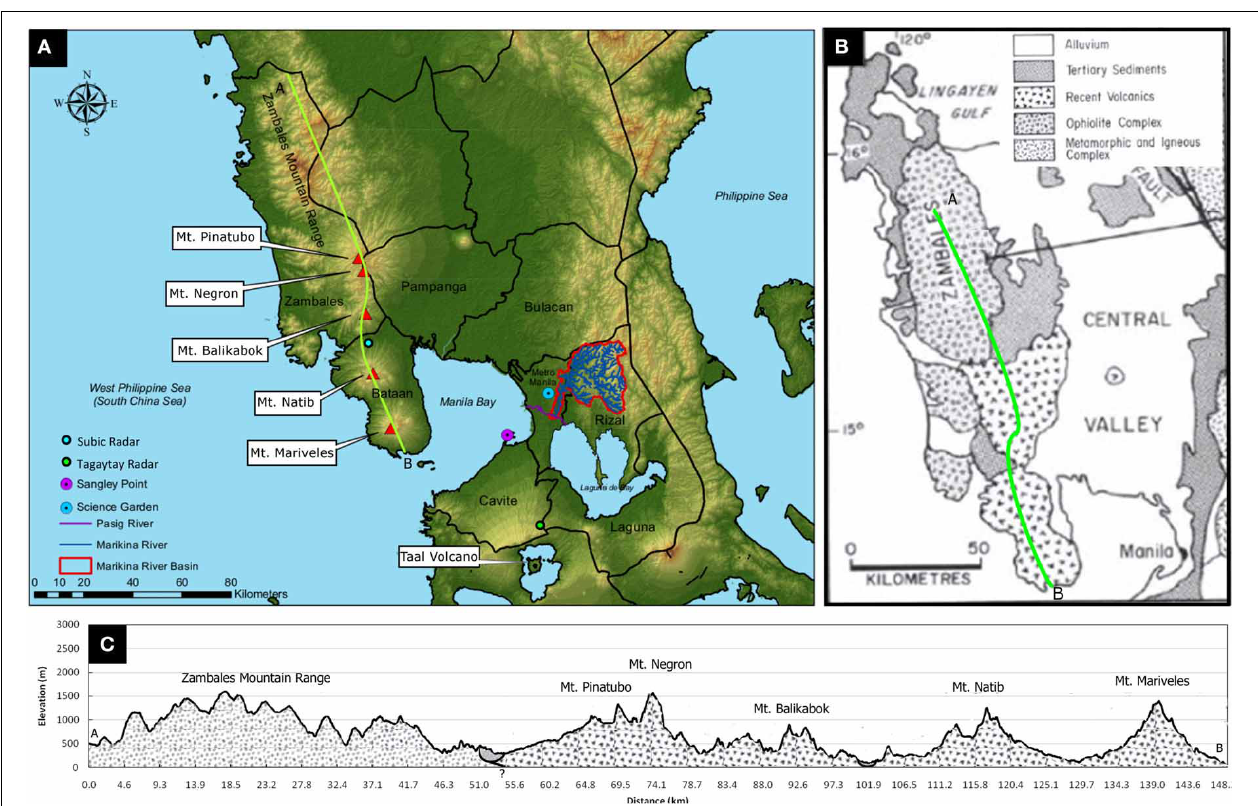
FIGURE 1 | (A) Elevation map of Metro Manila and surrounding provinces. Shown in the map is the Zambales Mountain Range and the volcanoes Pinatubo, Negron, Balikabok, Natib, and Mariveles (red triangles). The Subic Radar (blue dot) is situated along the Zambales Mountain range. The Marikina River watershed east of Metro Manila is shown in red outline, with blue-colored drainage network. The Marikina and Pasig